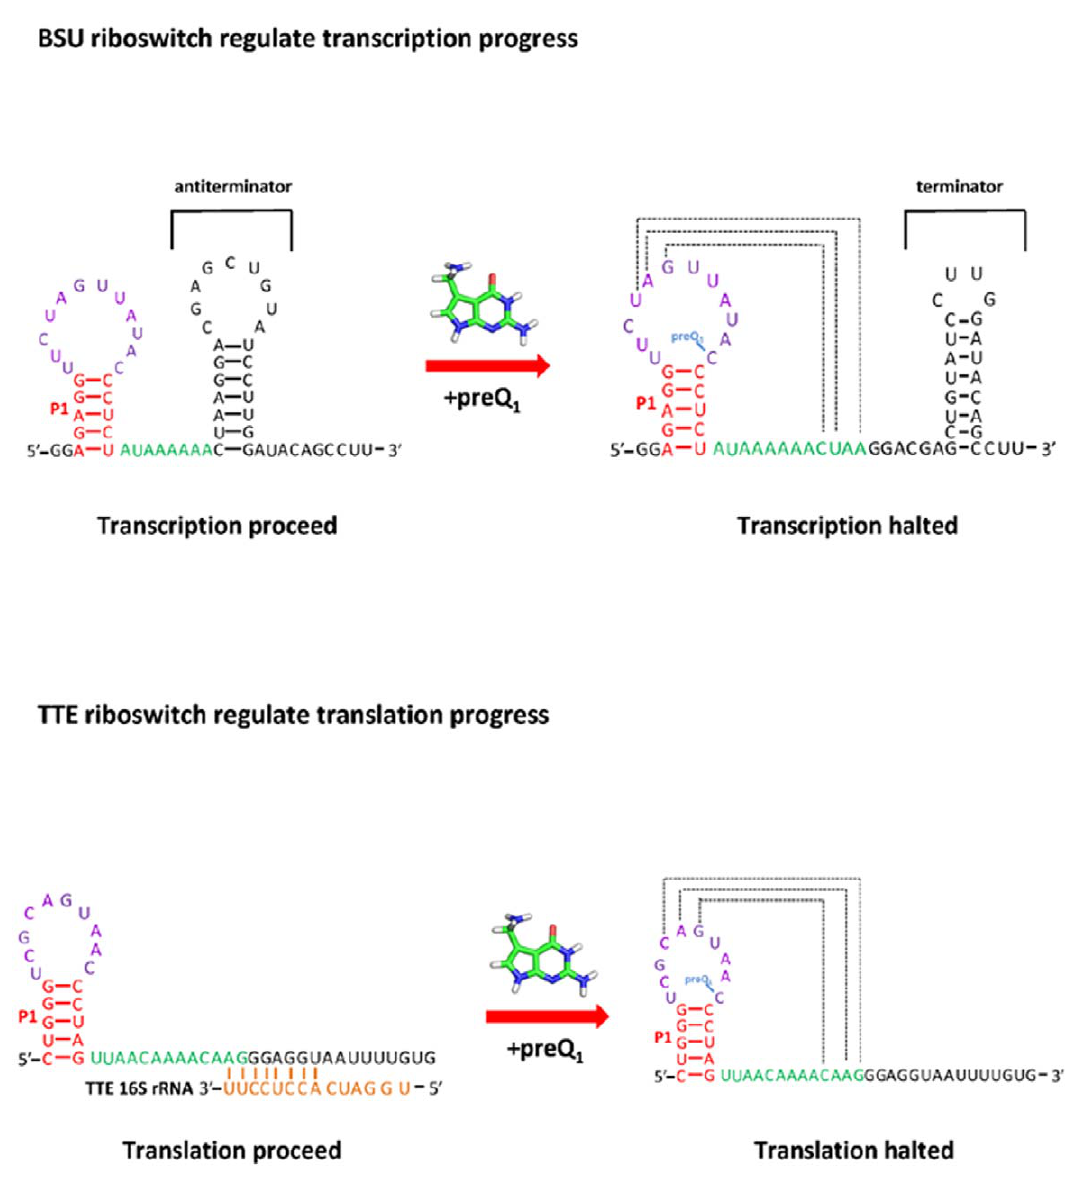
Figure 1. Regulation functions for two types of preQ 1 riboswitches.